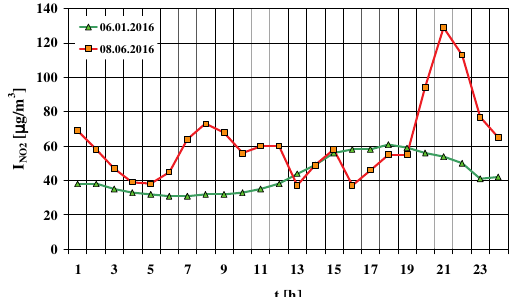
Fig. 9. The immission of nitrogen dioxide values obtained from Kraków– Dietla station on 6 January 2016 and 8 June 2016